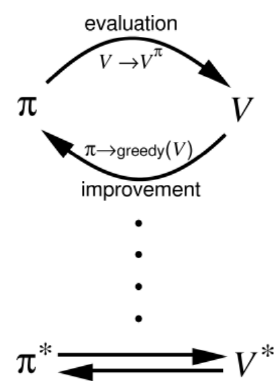
Figure 2. Policy–based recursion